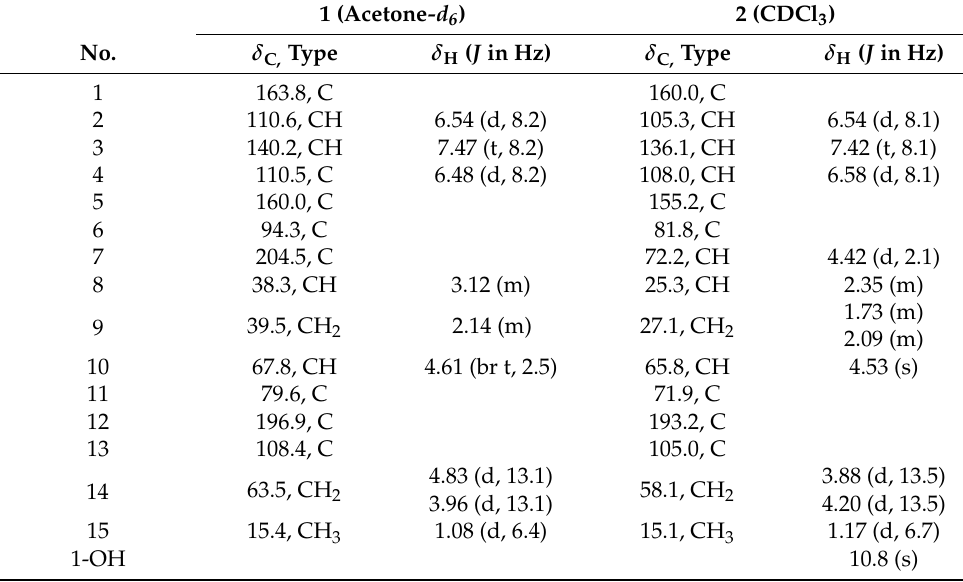
Table 1. 1 H NMR (600 MHz) and 13 C NMR (150 MHz) spectral data of 1 and 2 . 1 (Acetone -d 6 ) 2 (CDCl 3